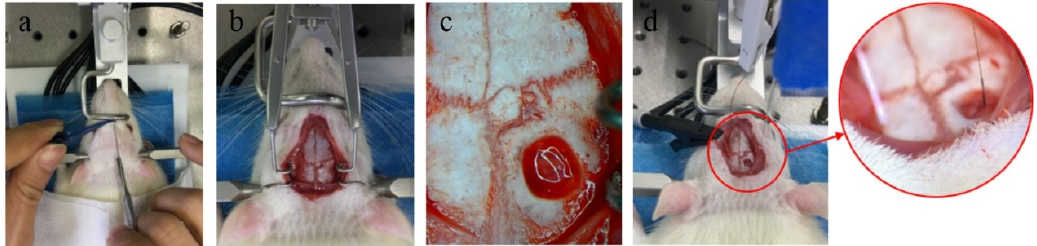
Figure 2. Acute electrophysiological recording process. ( a ) Strip the rat scalp; ( b ) expose skull; ( c ) skull drilling; ( d ) implant electrode.